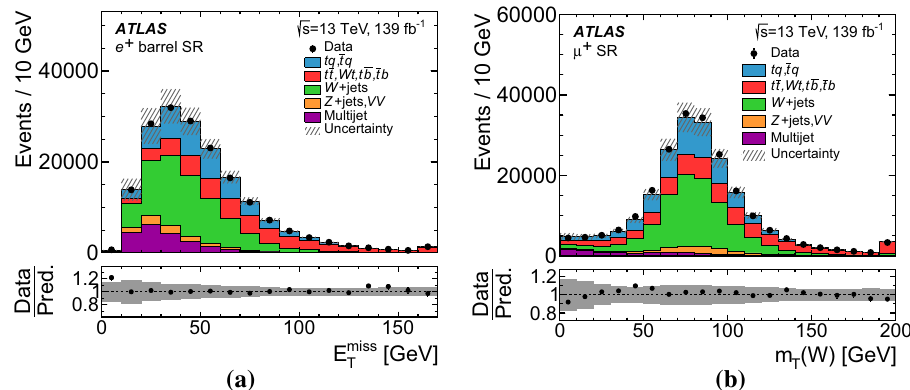
Fig. 2 Illustration of the estimation of the multijet background by fit- uncertainty due to limited sample size and the rate uncertainties of the different processes (20% for W +jets production, 30% for the mul- ting the E miss and m T ( W ) distributions in the analysis regions. As rep- T tijet background and 6% for the top-quark processes). The ratio of resentative examples, the E miss distribution is shown in the e + barrel T observed to predicted (Pred.) numbers of events in each bin is shown in channel in ( a ) and the m T ( W ) distribution is shown in the μ + chan- the lower panel. Events beyond the axis range are included in the last nel in ( b ). Both distributions are in the SR. The stacked histograms bin were normalised to the fit result. The uncertainty band represents the